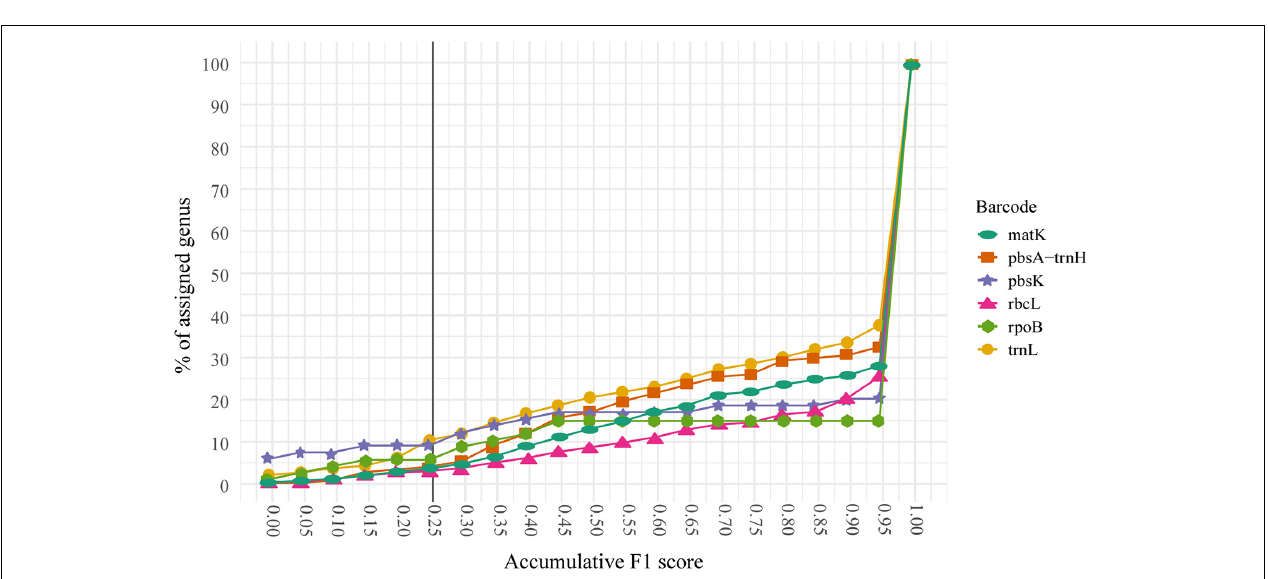
FIGURE 3 | Correct and Incorrect classifications for Genus (G) and Species (S) levels for all markers evaluated in the 5–20 dataset. The value corresponding to the percentage of correct assignments is shown in the bottom of the bar, while the value for incorrect assignments is right below the corresponding light green bar.